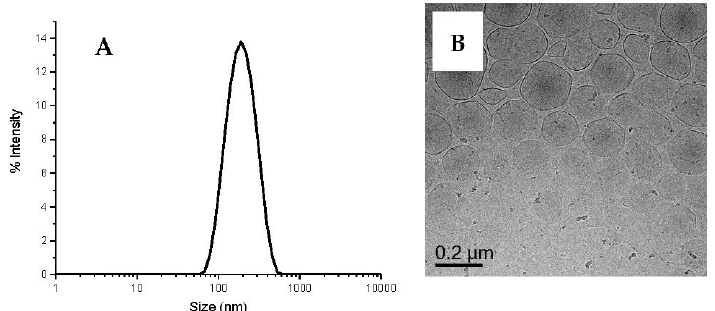
Figure 2. Size distribution ( A ) and cryo-TEM micrograph ( B ) of DODAB vesicles (10 mM) prepared in 0.5 mM NaCl (aq) . 0.5 mM NaCl (aq)